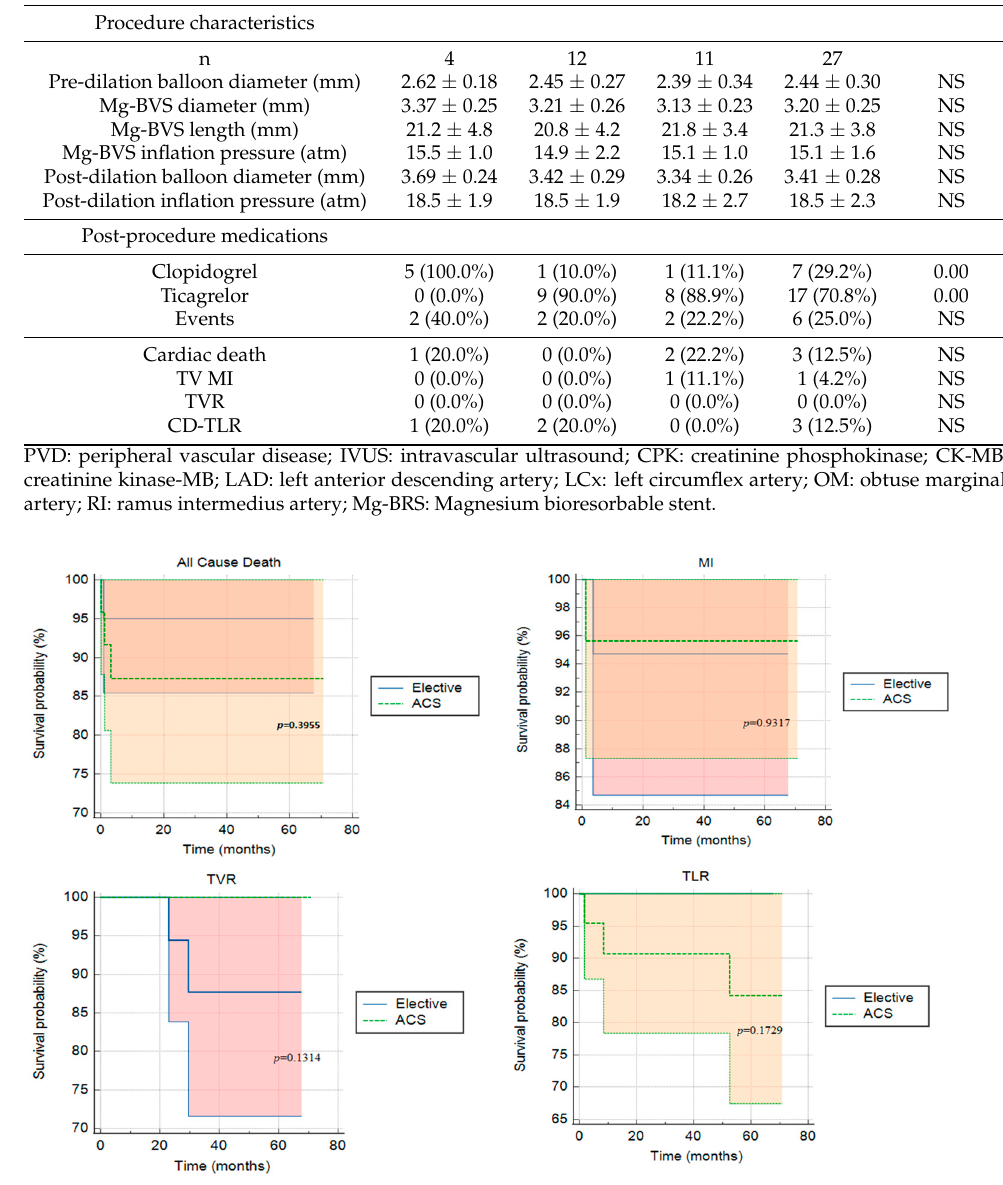
Figure 1. Kaplan–Meier survival curves between the elective and acute coronary syndrome (ACS) groups. MI = Myocardial Infarction; TVR = Target Vessel Revascularization; TLR = Target Lesion